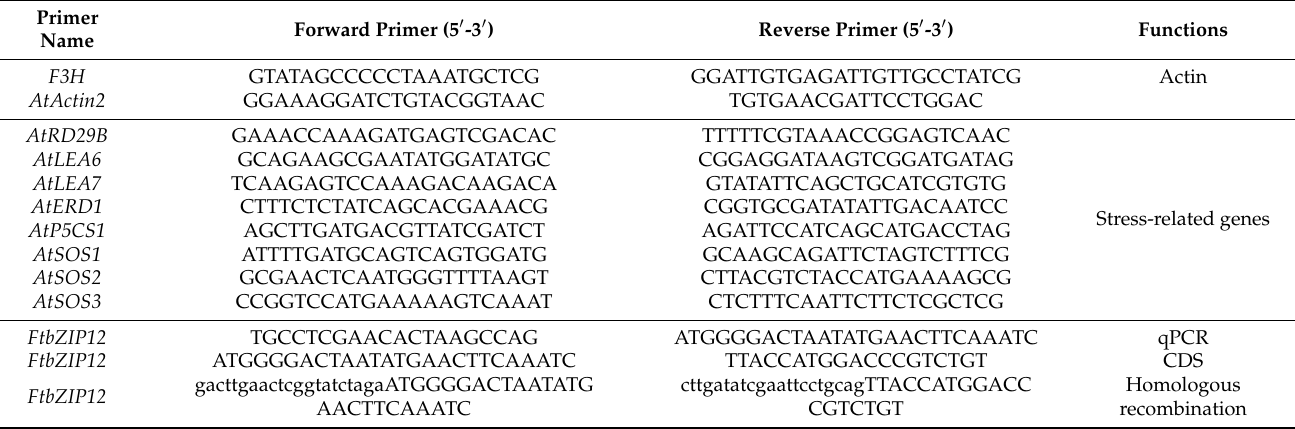
Table 1. List of primers in Arabidopsis and Tartary